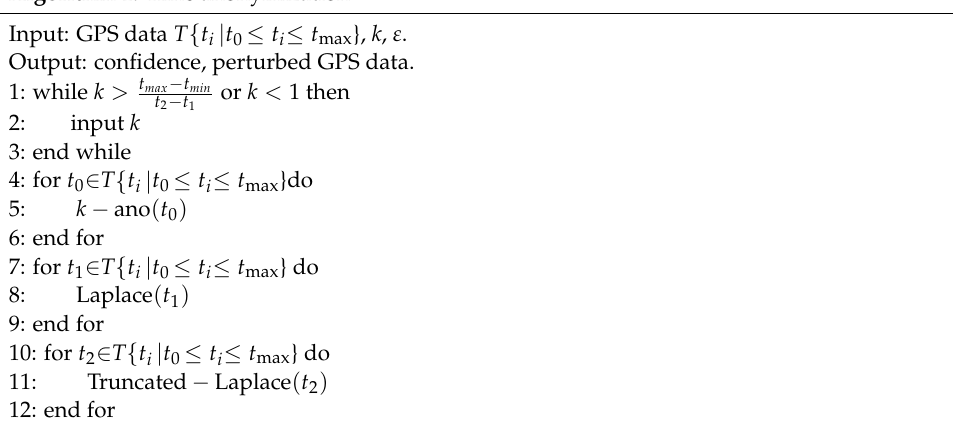
Algorithm 1: Time